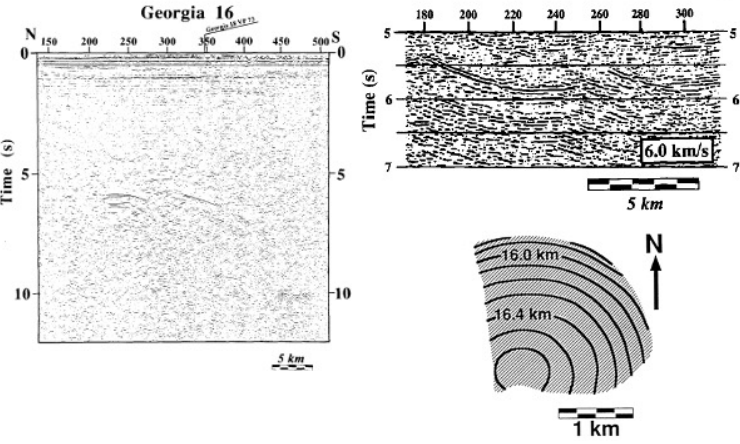
Figure 15. ( Left ) Unmigrated COCORP true amplitude section showing the Surrency Bright Spot [95]. ( Upper Right ) Blow up of migrated image of the Surrency Bright Spot [95]). ( Lower Right ) depth contour of the Surrency Bright Spot from the COCORP 3D seismic survey [97]. The “saucer” shape of this basement reflector is comparable to those associated with mafic intrusions imaged by 3D oil industry data and in outcrop